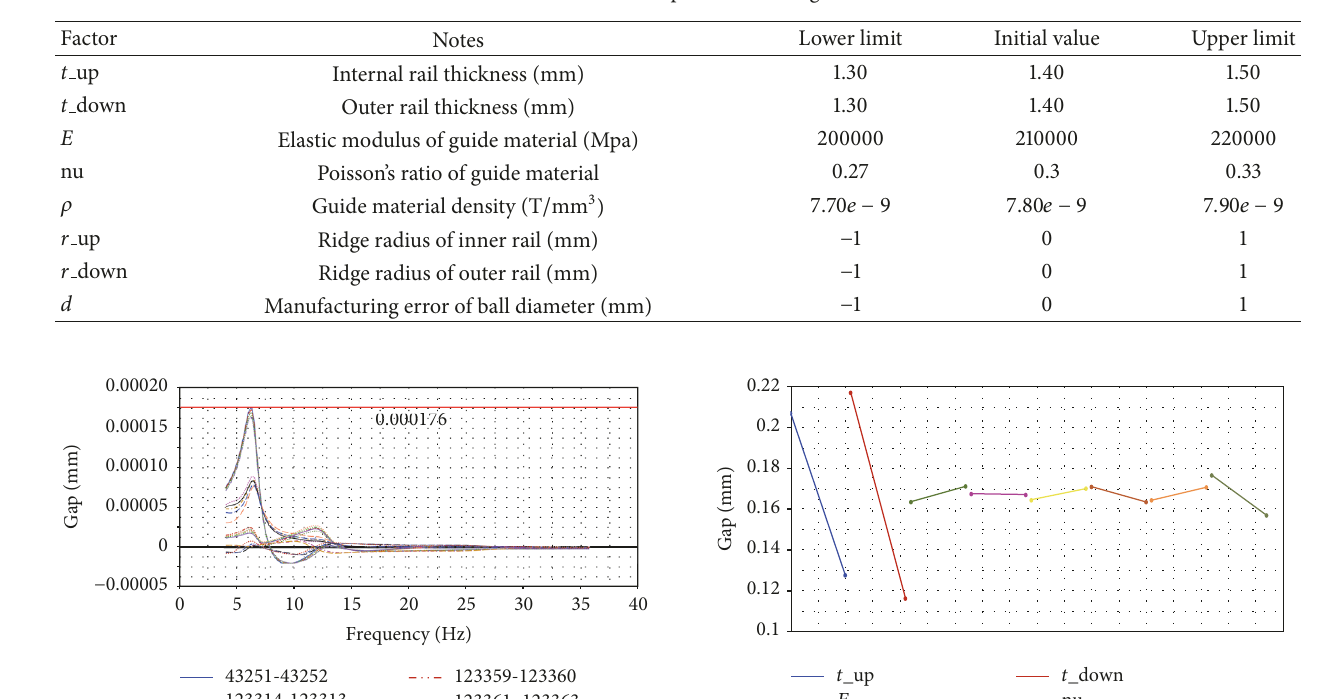
Table 7: Valve table of experimental design variable.